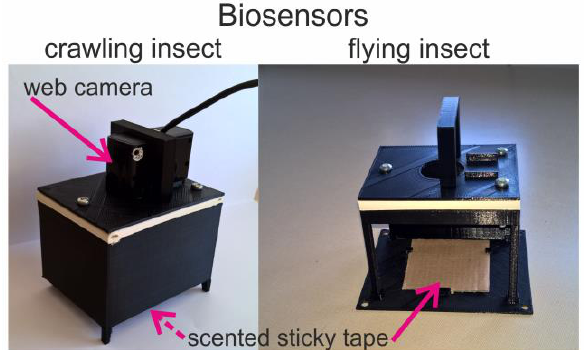
Figure 4. Unified platform of biosensors, based mostly on 3D printed components. The same camera top part can be used for detection of crawling or flying